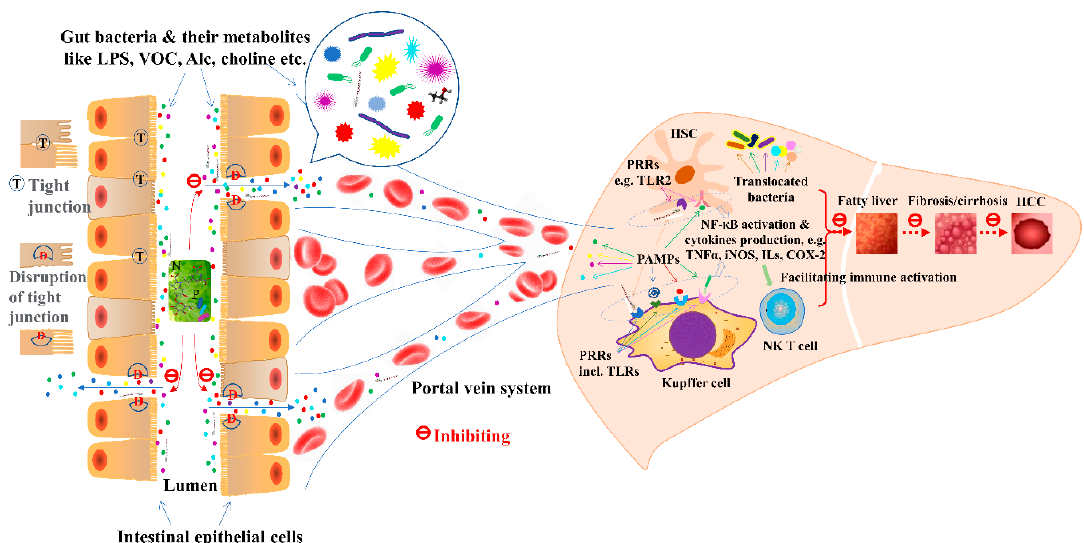
Figure 1. The inhibitory effects of natural products on the cascade of microbial translocation in liver disease progression. Abbr. : Alc, alcohol; D, disruption of tight junctions; HCC, hepatocellular carcinoma; HSC, hepatic stellate cell; ILs, interleukins; incl., including; LPS, lipopolysaccharide; N, natural products and bioactive components; PAMPs, pathogen-associated molecular patterns; PRRs, pattern recognition receptors; T, tight junction; TLRs, toll-like receptors; Treg, the regulatory T cell; VOC, volatile organic compounds.